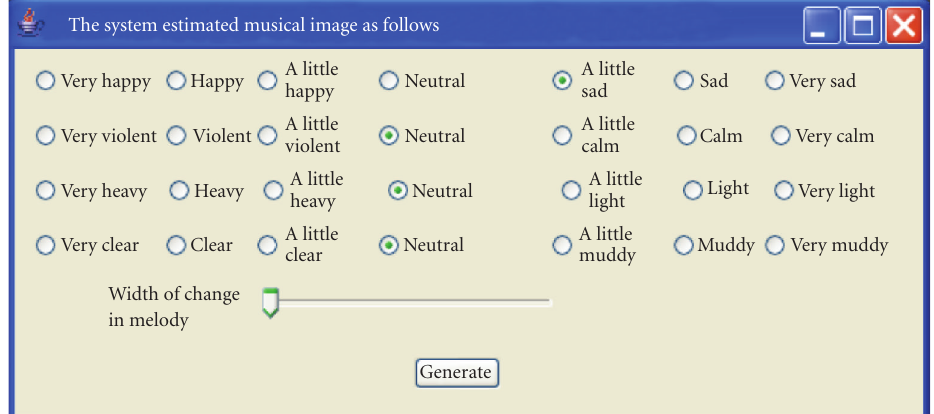
Figure 6: TIPs estimation by present system.